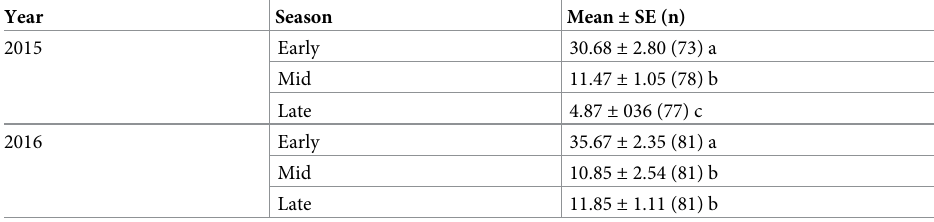
Table 2. Density of herbivorous insects per cm 2 area of sticky card early, mid, and late season in 2015 and 2016.